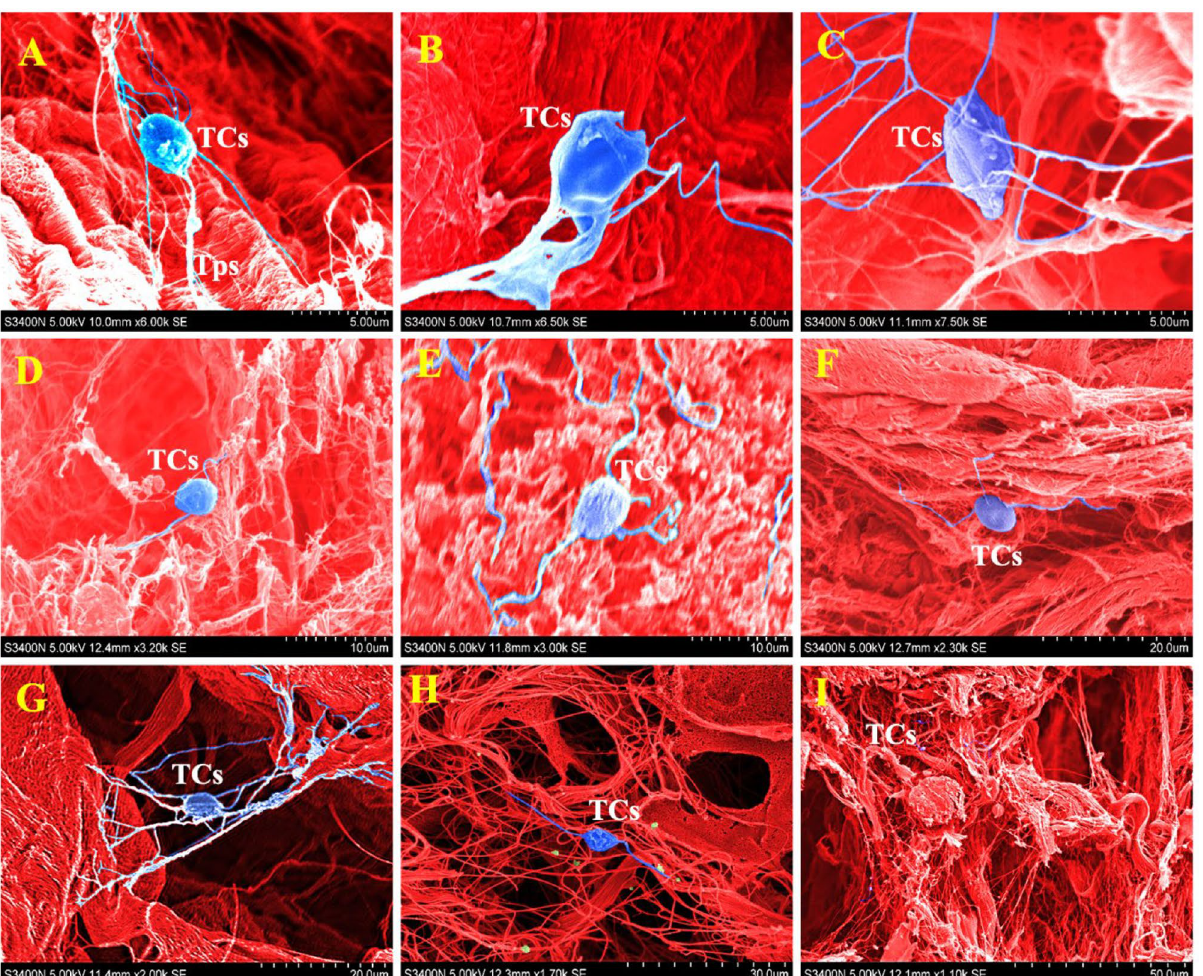
Figure 4. The localization of telocytes in the epididymis of yak by SEM. ( A ) The TCs were found in the epididymis of yak. There is a cytoplasmic projection structure in TPs, which has the typical characteristics of TCs cells. ( B ) TCs near the epididymis epithelium. ( C ) TCs in the interstitium of the epididymis. ( D , E ) TCs found in the stroma of the corpus epididymis. ( F ) TCs attached to the epididymis epithelium. ( G ) TCs form a network between the adjacent epitheliums. ( H ) The TCs in the interstitium of the epididymis cauda, with cell secretions were seen around them. ( I ) The cell population of TCs was found in the epididymis